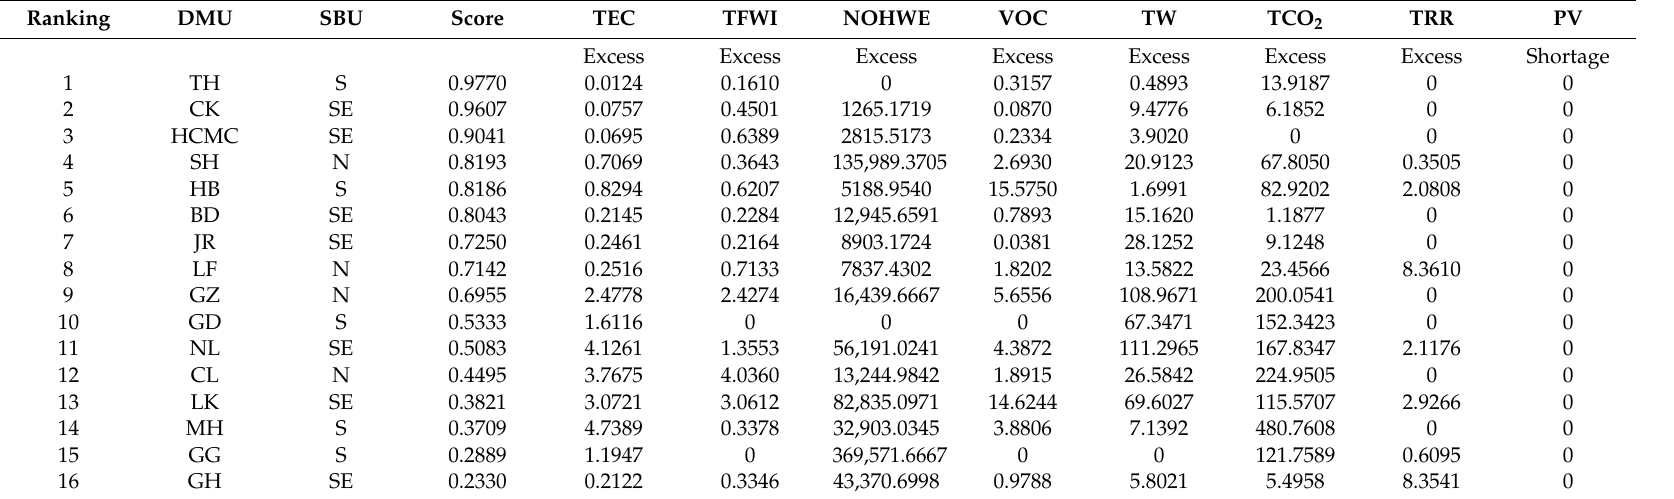
Table 4. E ffi ciency score and slacks of the bad-output CRS